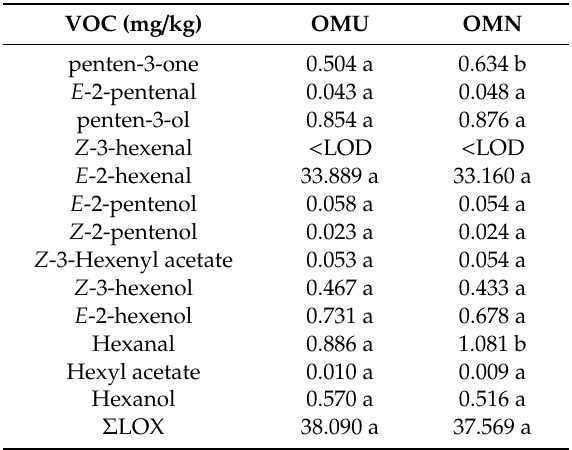
Table 1. Profile of the lipoxygenase LOX-related volatile organic compounds VOCs in the two analyzed samples. Results are expressed as mean of triplicate measurements. For each VOC, di ff erent letters indicate significant di ff erences between the two samples. EVOO from cultivar Coratina with ( OMU ) or without ( OMN ) using the ultrasound technology VOC (mg / kg) OMU OMN penten-3-one 0.504